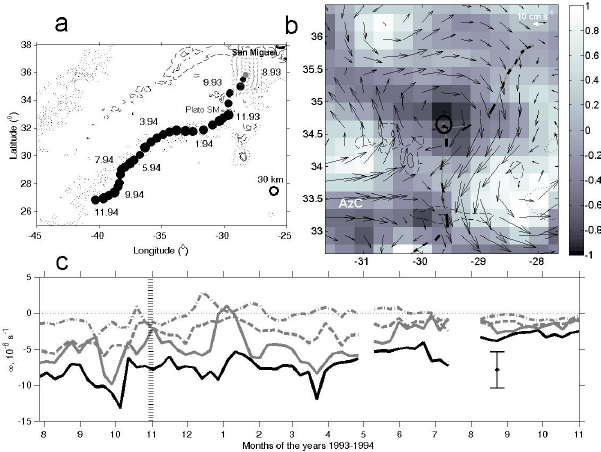
Fig. 1. Temporal evolution of the characteristics of meddy Zoe and of its surface signature. (a) Track of Zoe with month-year marked (the direction of meddy movement is to west). The width of the filled-in circles represents the RAFOS float rotation radius in km. Typical distribution of surface geostrophic currents (cms − 1 ) over the meddy is presented with grey arrows (AVISO altimetry data-set). The corresponding position of the meddy is marked with the grey filled-in circle. Black lines mark depth contours: 1000m (solid), 2000m (dashed), 4000m (dotted). (b) Example of surface vorticity field (10 − 5 s − 1 , colour) and geostrophic currents (cms − 1 ) derived from AVISO altimetry with the meddy position marked with a black ring at 22.11.1994. The grey line is the track of meddy centre: the meddy moved from the right (13.09.1994) to the left (10.02.1995) of the plot. (c) Time evolution of meddy peak relative vorticity (solid black line, 10 − 6 s − 1 ) , of the mean relative vortic- ity of the meddy surface signal at r < 20km (solid thin grey line, 10 − 6 s − 1 ) , at r ∼ 20–60km (dashed thin grey line, 10 − 6 s − 1 ) , at r ∼ 60–80km (dash-dotted thin grey line, 10 − 6 s − 1 ) . The SLH are derived from AVISO altimetry. The vertical segments show twice the maximum error of peak relative vorticity (see Sect. 2).